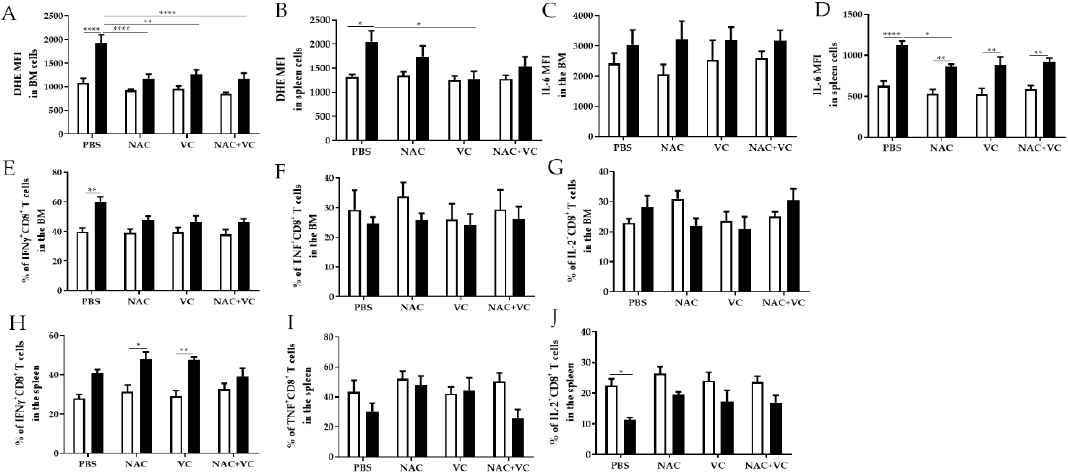
Figure 4. ROS levels and pro-inflammatory molecules in the BM and spleen. ( A ) ROS levels ( = DHE Mean Fluorescence Intensity, MFI) in the BM, ( B ) ROS levels in the spleen, ( C ) IL-6 MFI in the BM, ( D ) IL-6 MFI in the spleen, ( E ) IFN γ + CD8 + T cells in the BM, ( F ) TNF + CD8 + T cells in the BM, ( G ) IL-2 + CD8 + T cells in the BM, ( H ) IFN γ + CD8 + T cells in the spleen, ( I ) TNF + CD8 + T cells in the spleen, ( J ) IL-2 + CD8 + T cells in the BM of young (white columns) and old (black columns) mice treated with PBS, NAC, Vc, or NAC + Vc. Data are shown as mean ± SEM. Two-way ANOVA, Tukey post-hoc test. * p < 0.05; ** p < 0.01; **** p < 0.0001.